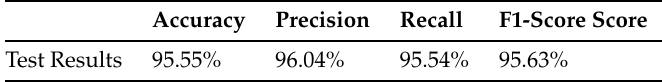
Table 18. Evaluation results of the model trained by CNN network.